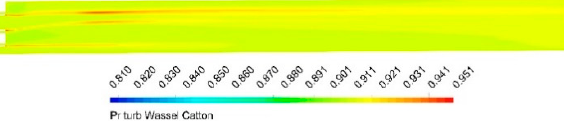
Figure 22. 𝑃𝑟 (cid:3047) field in the cylindrical part given by the Wassel and Catton model.